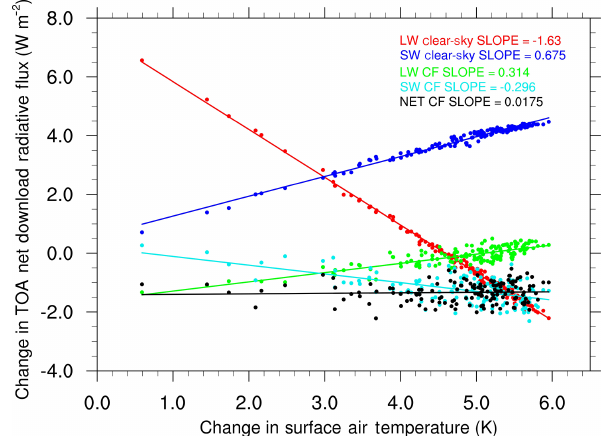
Figure 16. Results from the abrupt quadrupling of CO 2 experiment. The relationship between the change in the global mean radiative fluxes and global mean surface air temperature. The climate feed- back parameters (Wm − 2 K − 1 ) for the TOA longwave clear-sky (red), shortwave clear-sky (green), longwave cloud forcing (blue), shortwave cloud forcing (light blue), and net cloud radiative effect (black) are − 1 . 63, 0.675, 0.31, − 0 . 30, and 0.02Wm − 2 K − 1 , re- spectively.